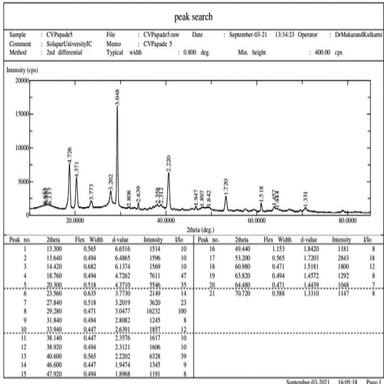
XRD analysis of 1 0.5 % nano mixed -PCM.